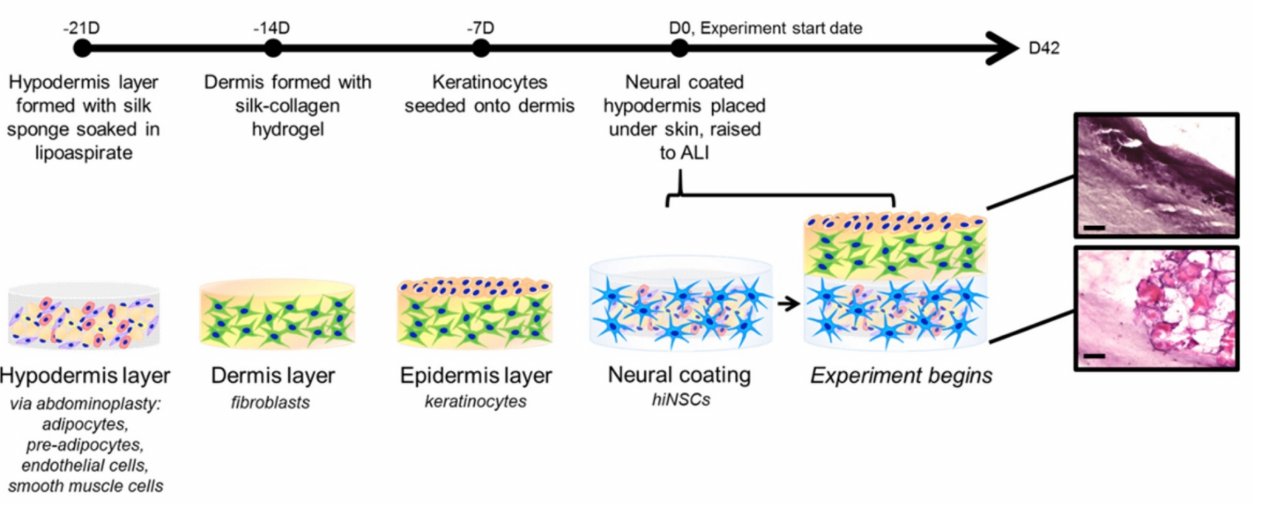
Figure 6. Construction of an HSE with a nervous system and hypodermis. Adapted with permission from [118], published by Elsevier,